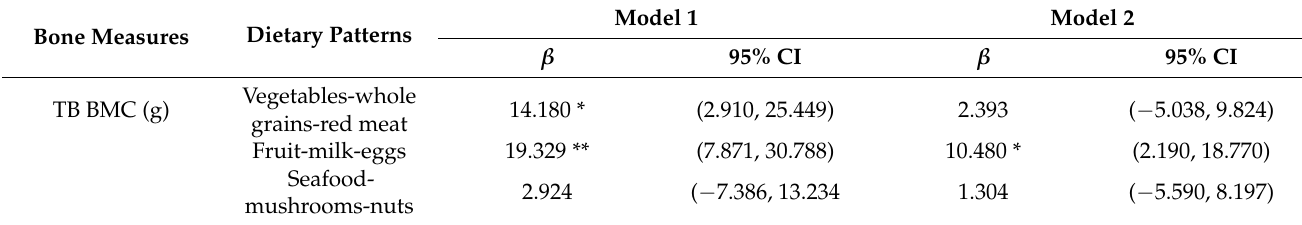
Table 3. Multiple linear regression analysis between dietary patterns and bone